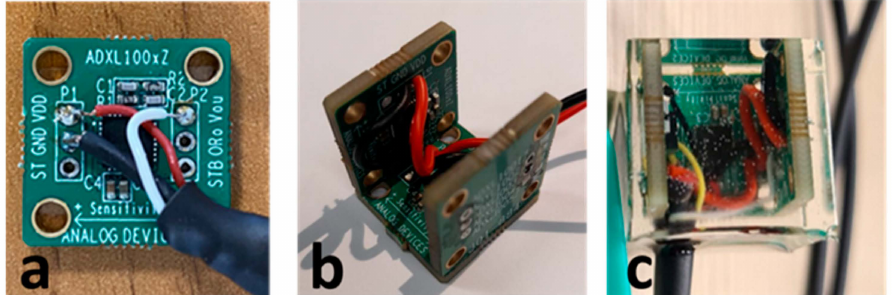
Figure 4. The MDUT elements: ( a ) single sensing element board, ( b ) multicomponent assembly, ( c ) epoxy